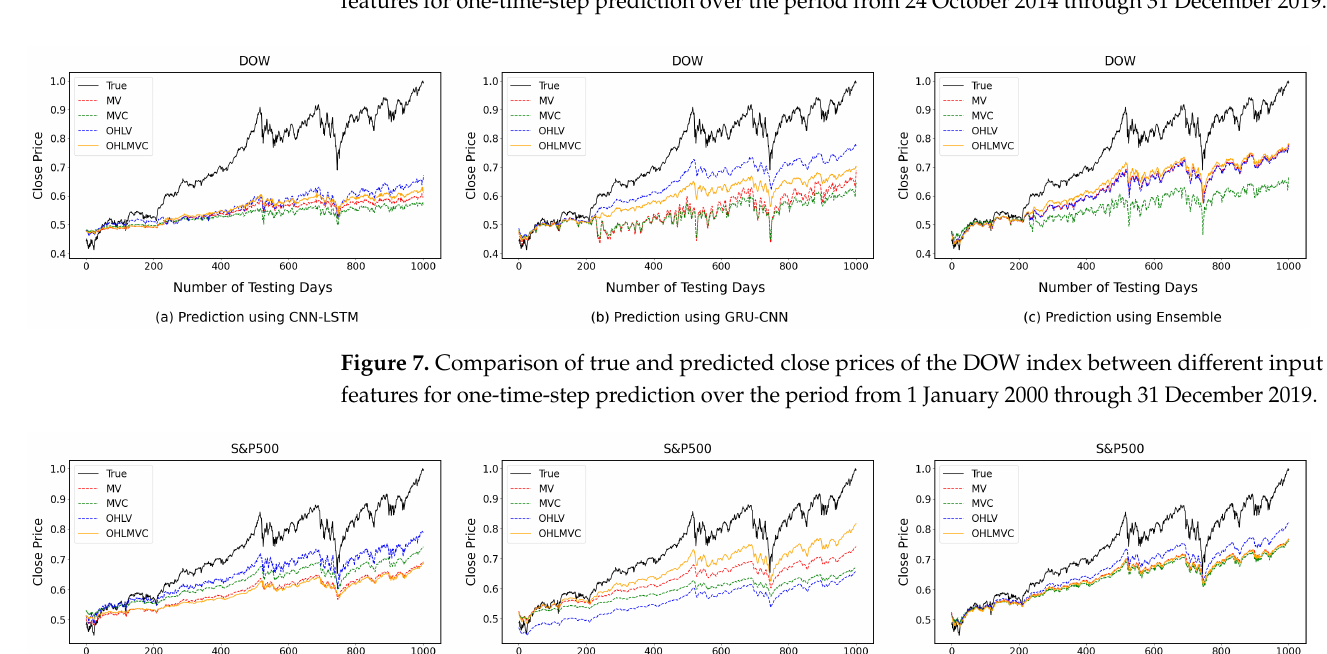
Figure 6. Comparison of true and predicted close prices of the DAX index between different input features for one-time-step prediction over the period from 24 October 2014 through 31 December 2019.